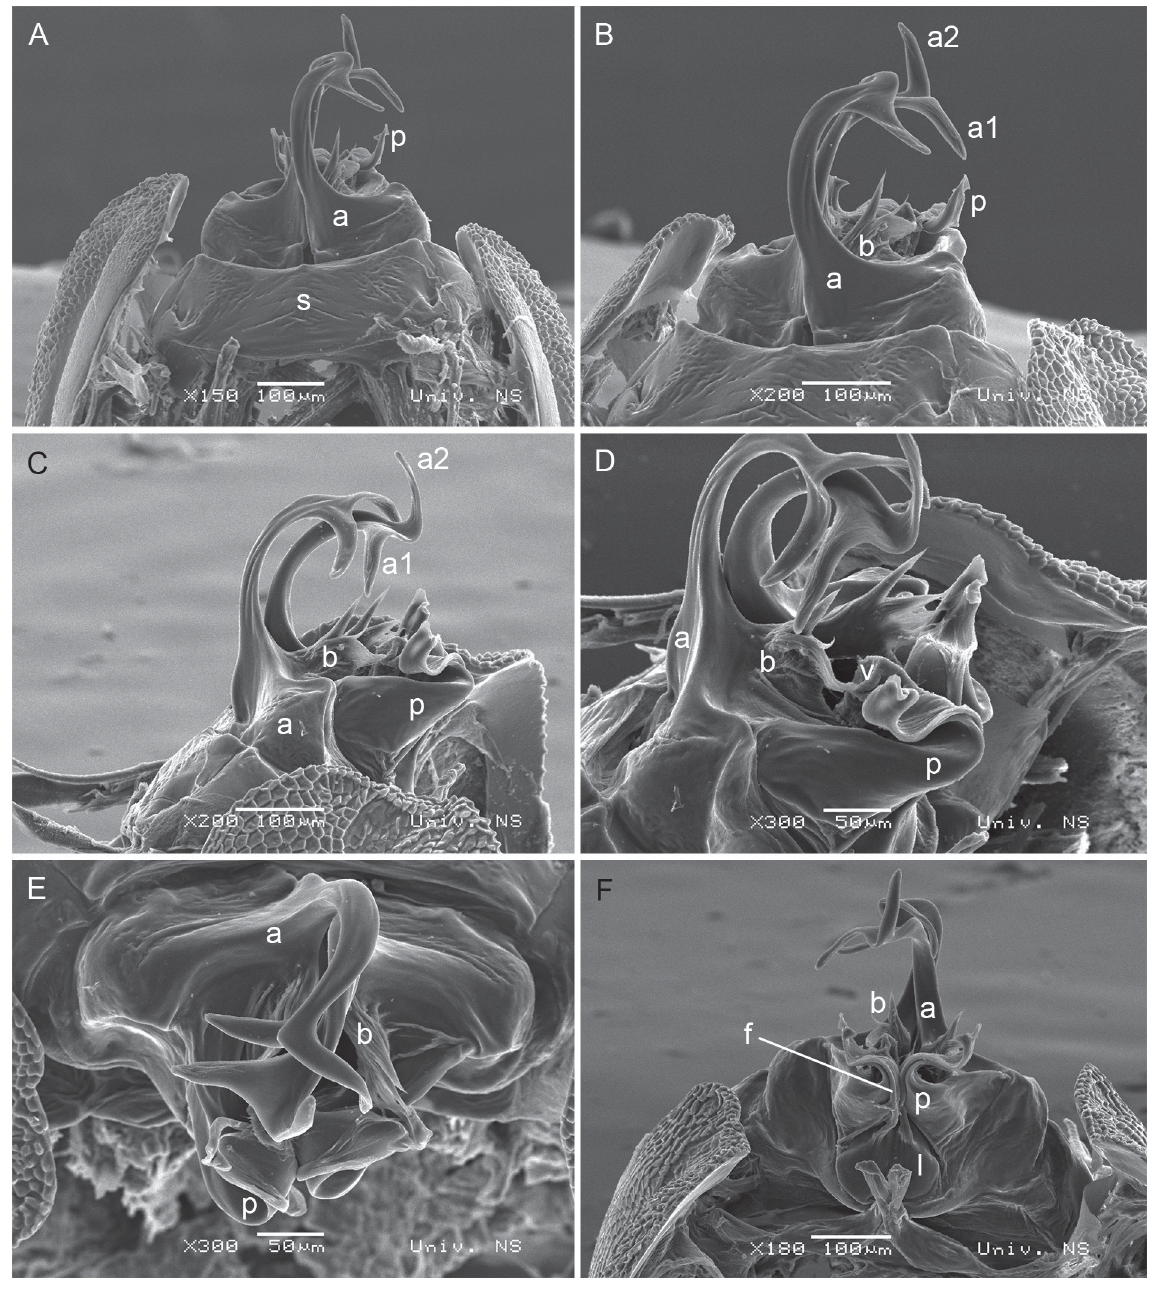
Fig. 5. Biokoviella mosorensis Antić & Dražina sp. nov., ♂, paratype, gonopods. A . Anterior gonopods, anterior view. B . Anterior gonopods, antero-lateral view. C . Anterior gonopods, lateral view. D . Anterior gonopods, latero-distal view. E . Anterior gonopods, distal view. F . Anterior and posterior gonopods, posterior view. Abbreviations: see Material and